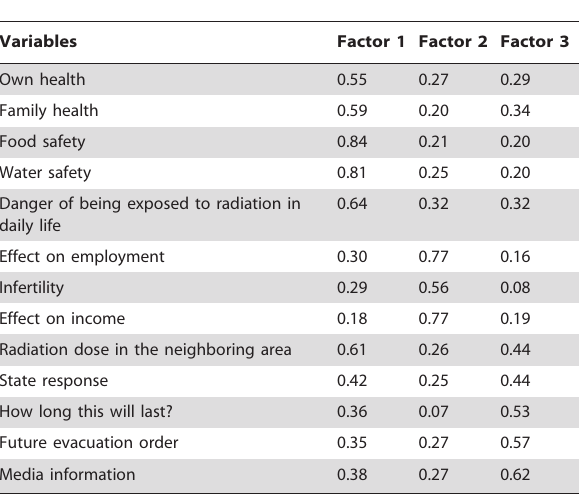
Table 2. Factor loadings for pre-seminar variables.